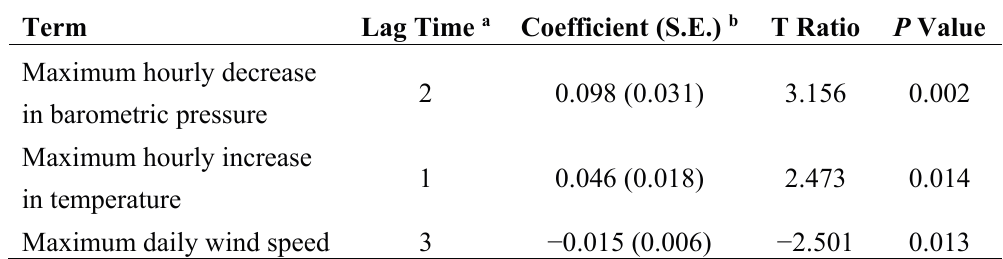
Table 3. Multivariate time-series analysis model for acute phase of chronic periodontitis without direct-triggered episodes ( r 2 =